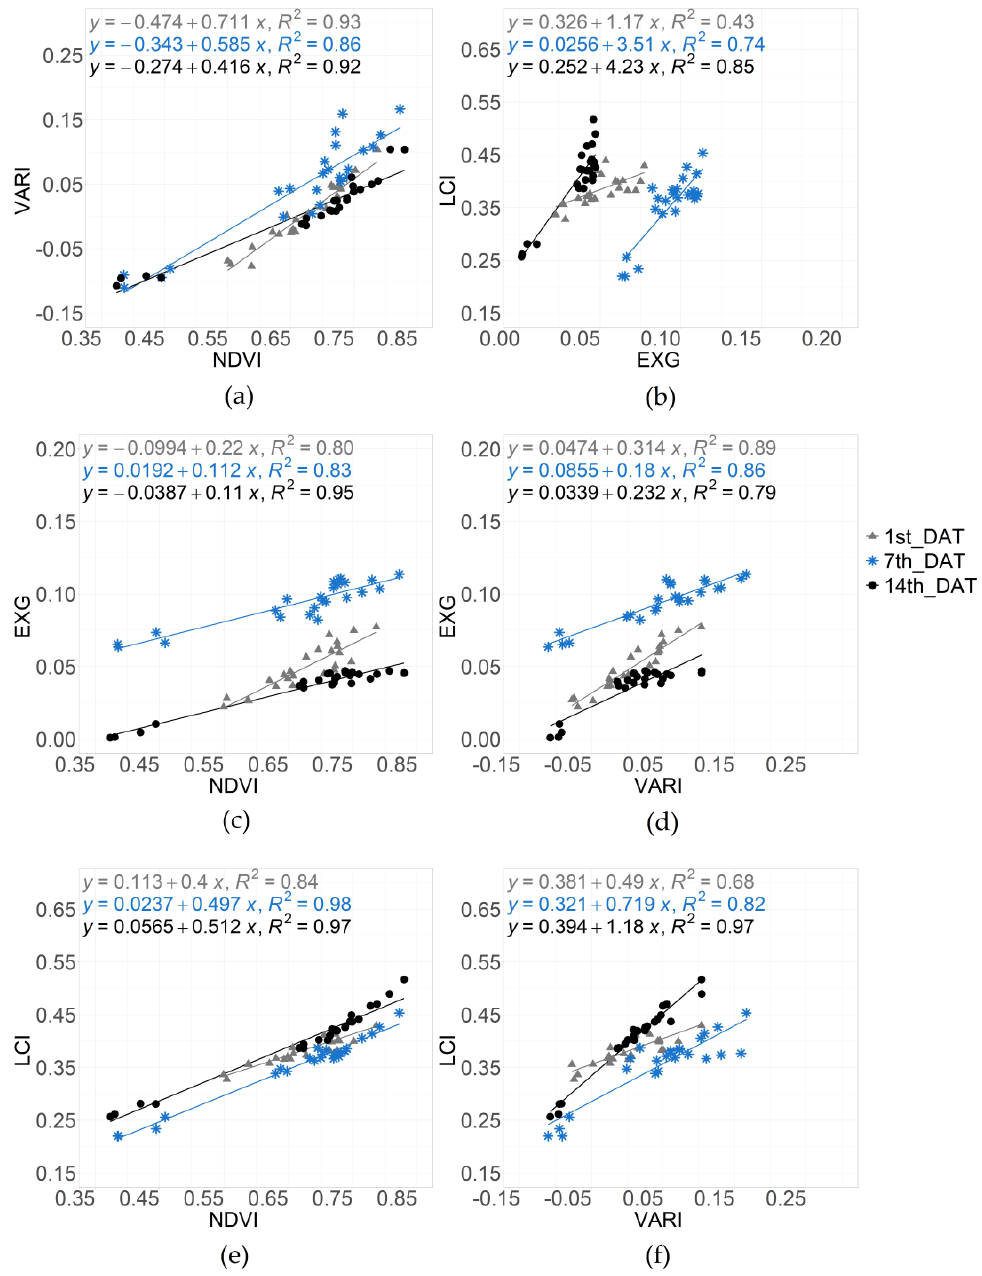
Figure 11. ( a – f ): Relationship between VIs (absolute values) in 2021. Linear regression analysis ( p < 0.05).